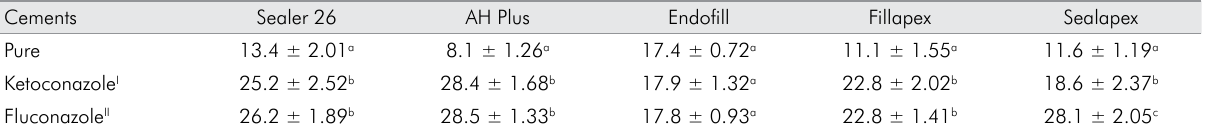
Table 2. Mean and standard deviation of inhibition halos (mm) of the sensitivity of C. albicans to sealers, pure and following addition of antifungals in 24 h.